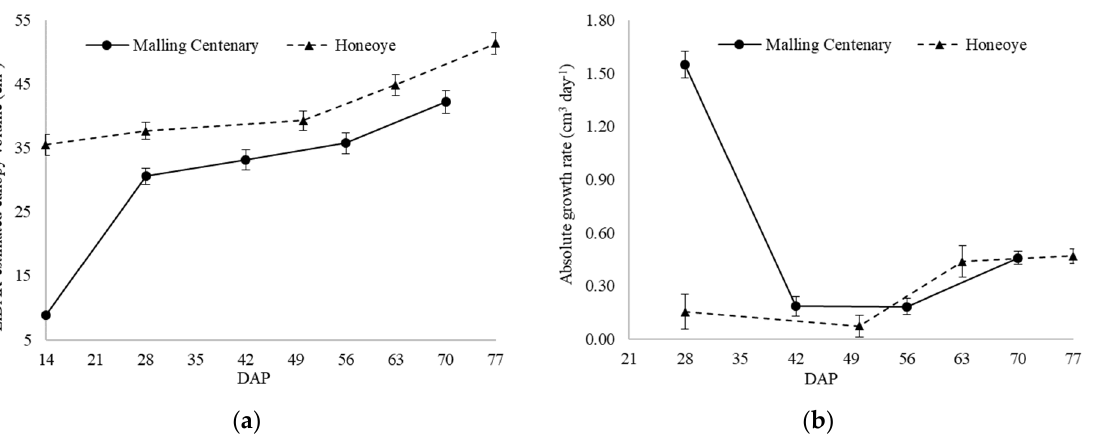
Figure 6. ( a ) Increase in strawberry canopy volume estimated from LiDAR point cloud and ( b ) ab- solute growth rate (cm 3 day − 1 ) of two strawberry cultivars in term of plant volume over time in days after planting (DAP).